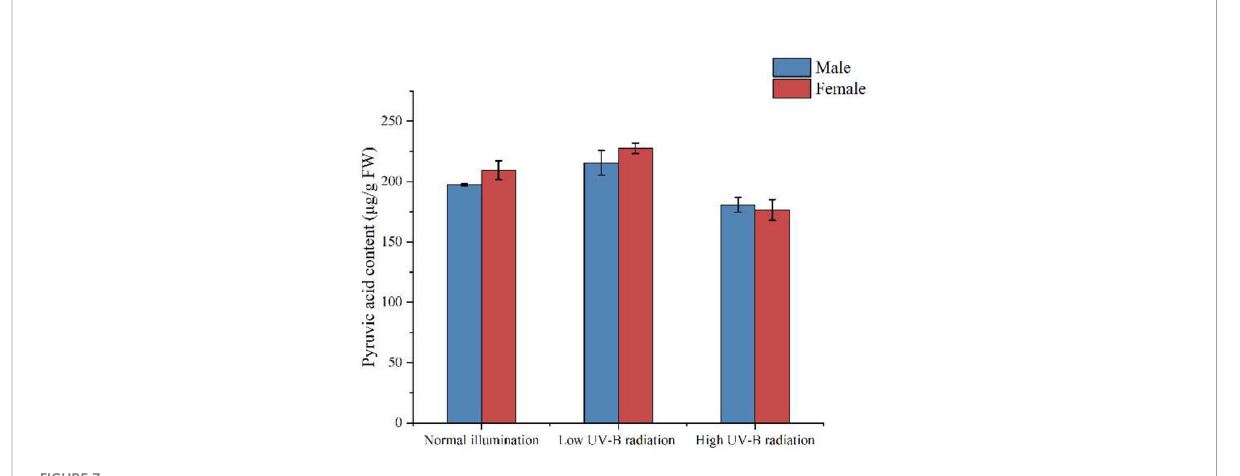
FIGURE 7 The amount of pyruvate in male and female S. thunbergii under different